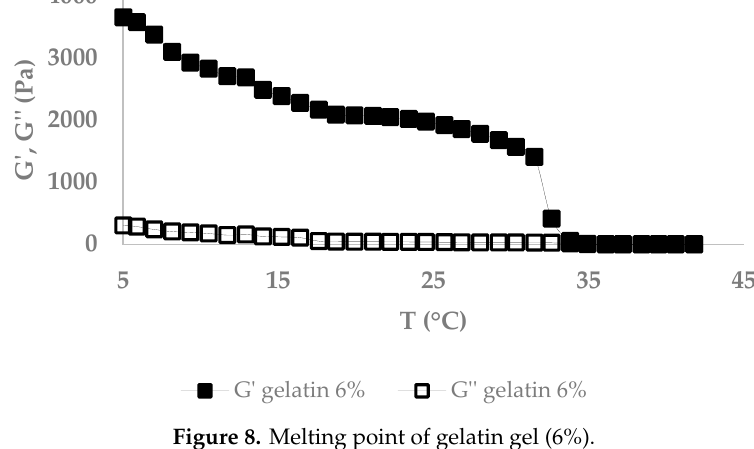
Figure 7. Molecular structure of 8-O-4 diferulic acid with MS/MS fragmentation sites.